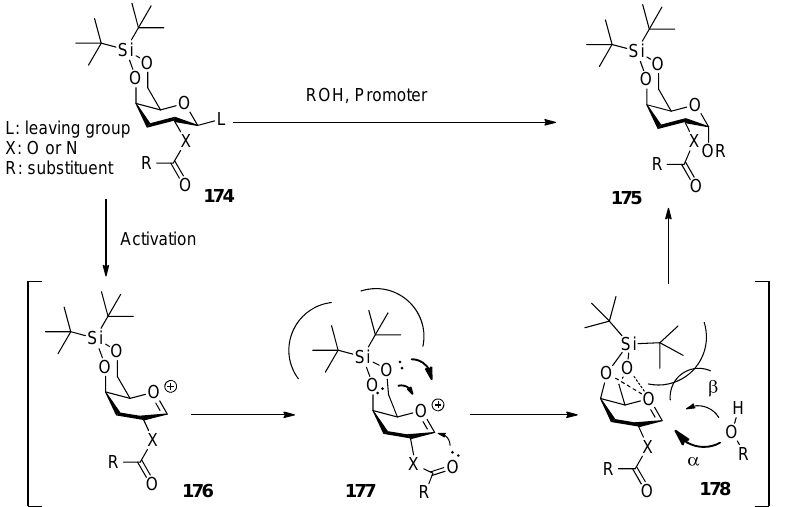
Figure 6. Proposed reaction mechanism for the DTBS-directed α